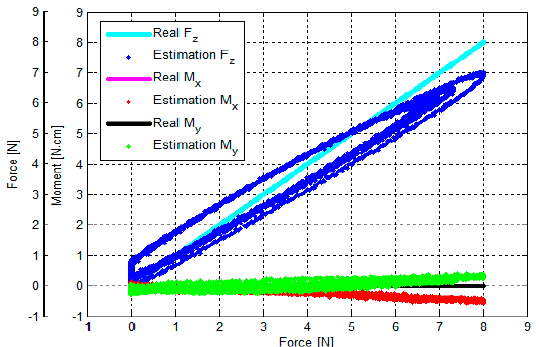
Figure 14. Comparison between real and estimated F z values: an external force was applied to and released from point ⓪ by the sensor calibration device as shown in Figure 12 (note that the values of M x and M y overlap, being both zero at all times).